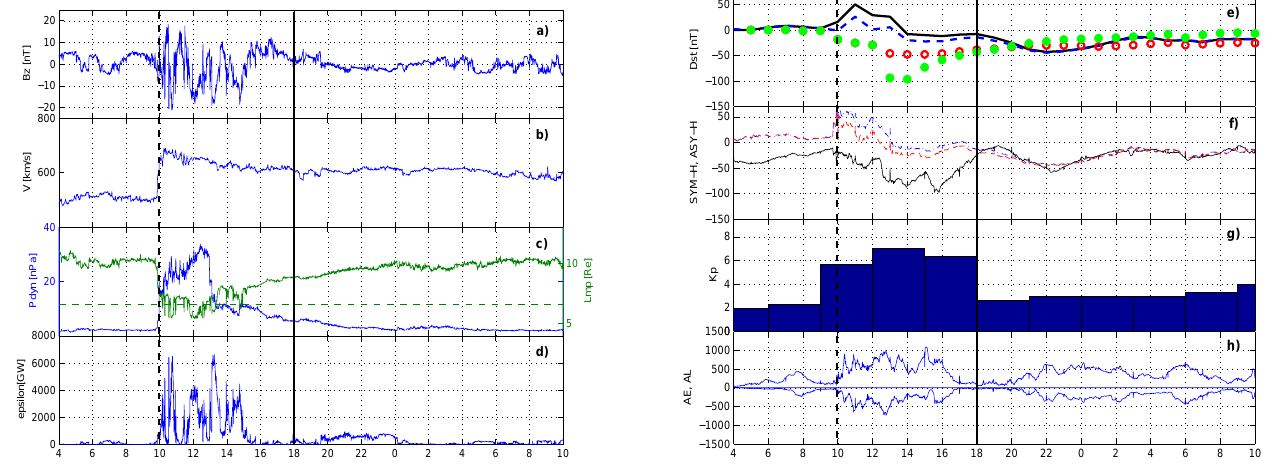
Fig. 4. Solar wind parameters and geomagnetic indices for a 30-h interval from 13 July, 04:00 UT–14 July, 10:00 UT, 2000 measured by ACE. The panels from top to bottom are the same as in Fig. 2. The dashed line indicates the shock and the solid line the arrival of the CME.